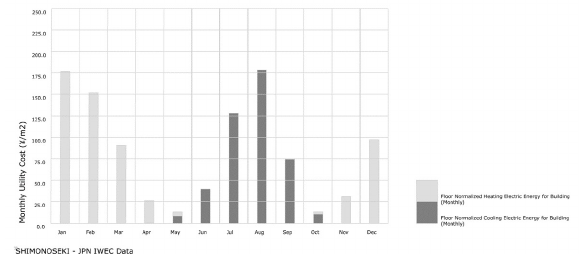
Fig. 8. Monthly utility costs for minimum benchmark model.